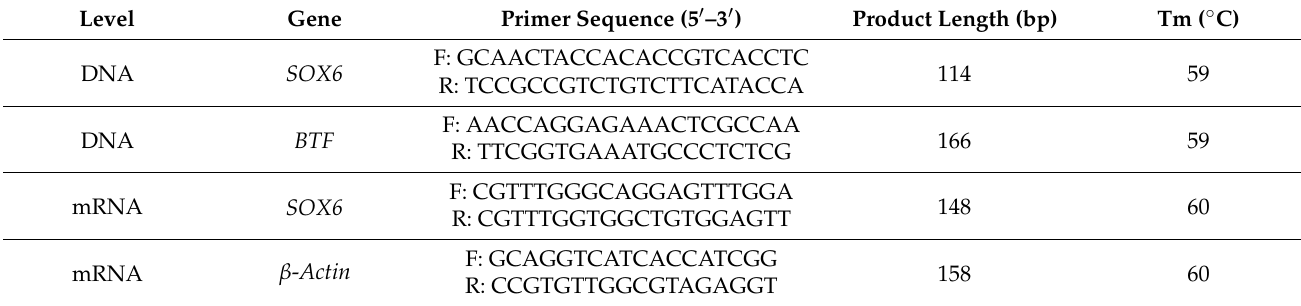
Table 2. Details of